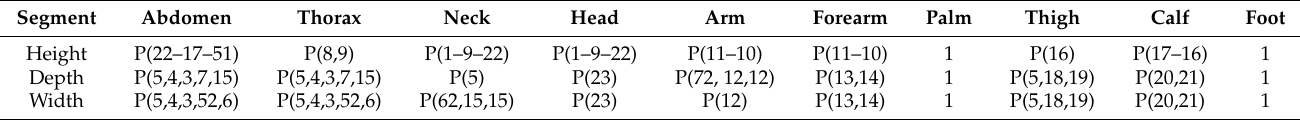
Table 4. Personalization coefficients of particular segments. The numbers in brackets denote the particular dimension. Segment Abdomen